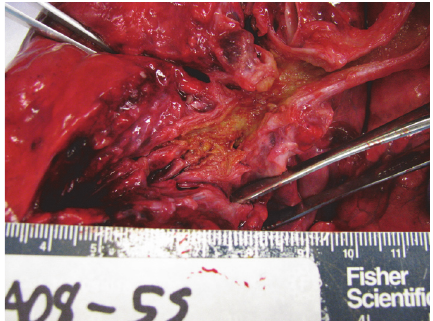
Figure 4: Autopsy: posterior view of left bronchial tree demon- strating the complete filling of even most distal airways with yellow gelatinous material.